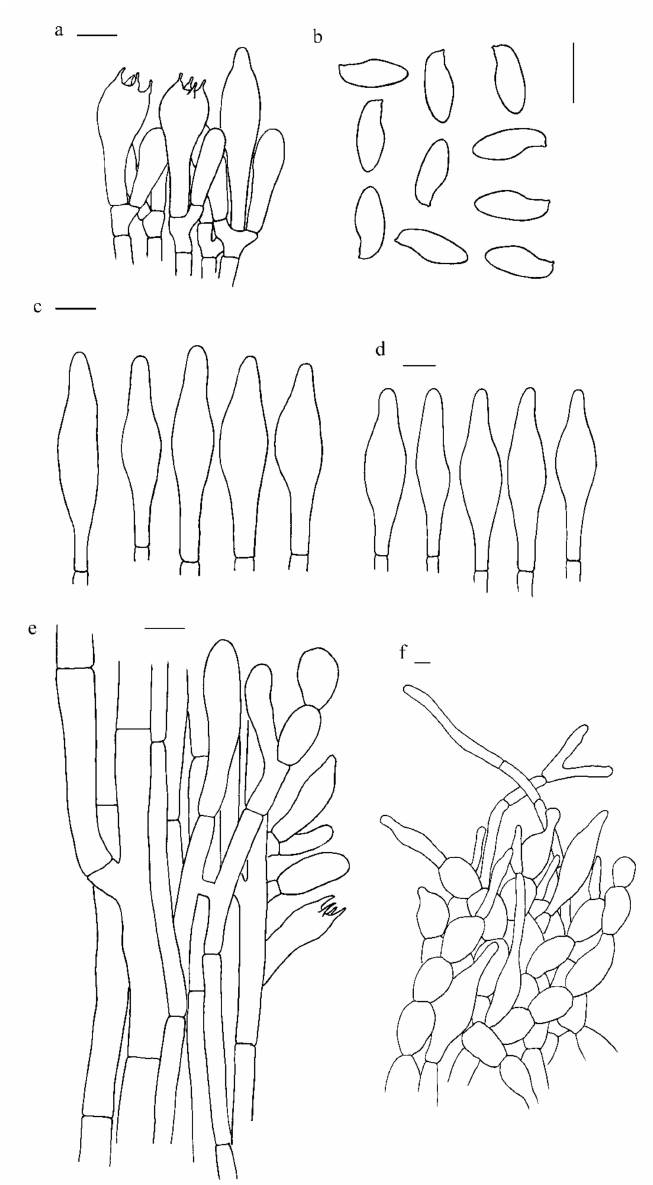
Figure 5. Microscopic features of H. albidum (Type, KUN-HKAS81120). ( a ). Hymenium and subhy- menium; ( b ). Basidiospores; ( c ). Cheilocystidia; ( d ). Pleurocystidia; ( e ). Stipitipellis; ( f ). Pileipellis. Bars : a = 20 µ m, b = 30 µ m, c–e = 20 µ m, f = 10 µ